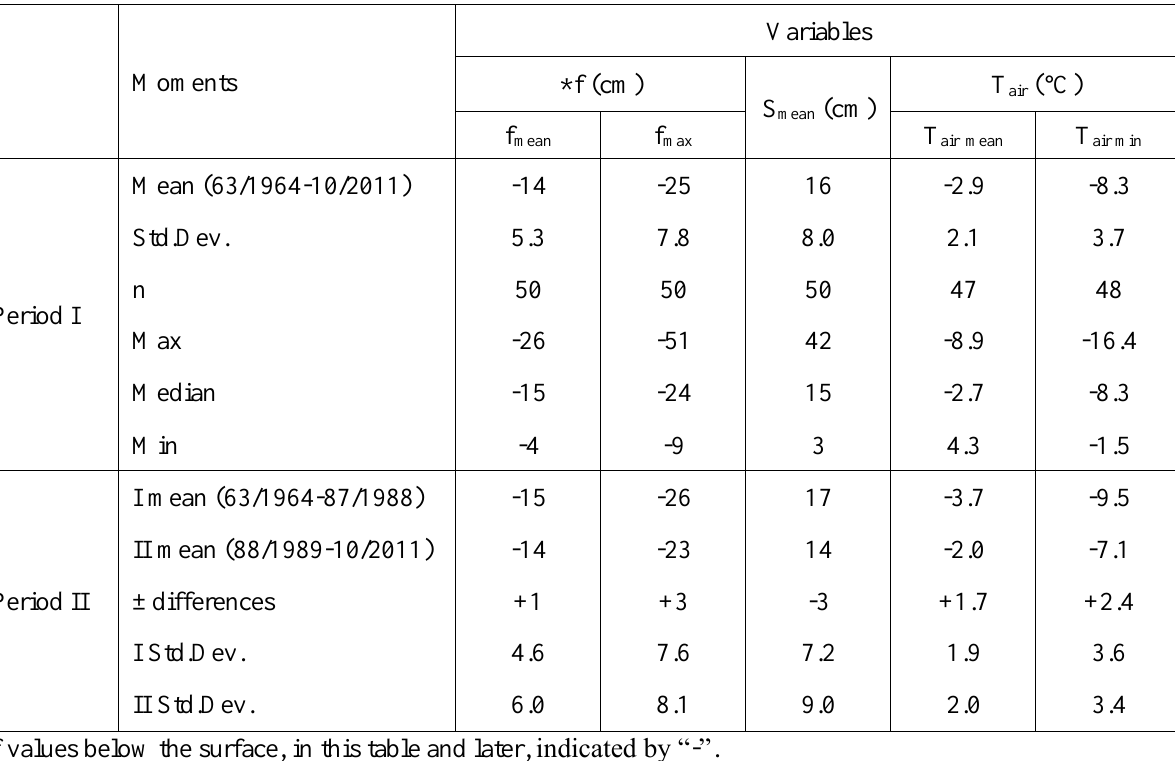
Table 2. Statistics of long-term monthly mean and maximum of soil frost (f depth (S ), air temperature (T mean (Periods I and II, respectively).